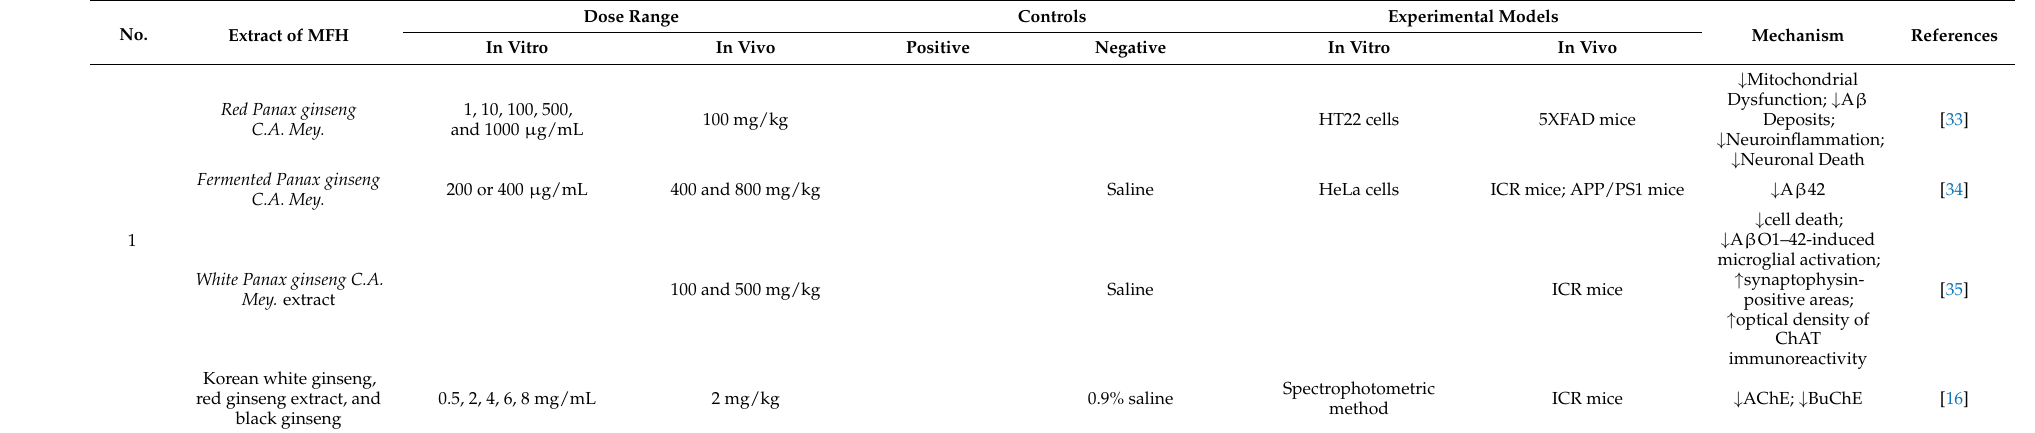
Table 4. Extract from MFH on the role and mechanism of Alzheimer’s